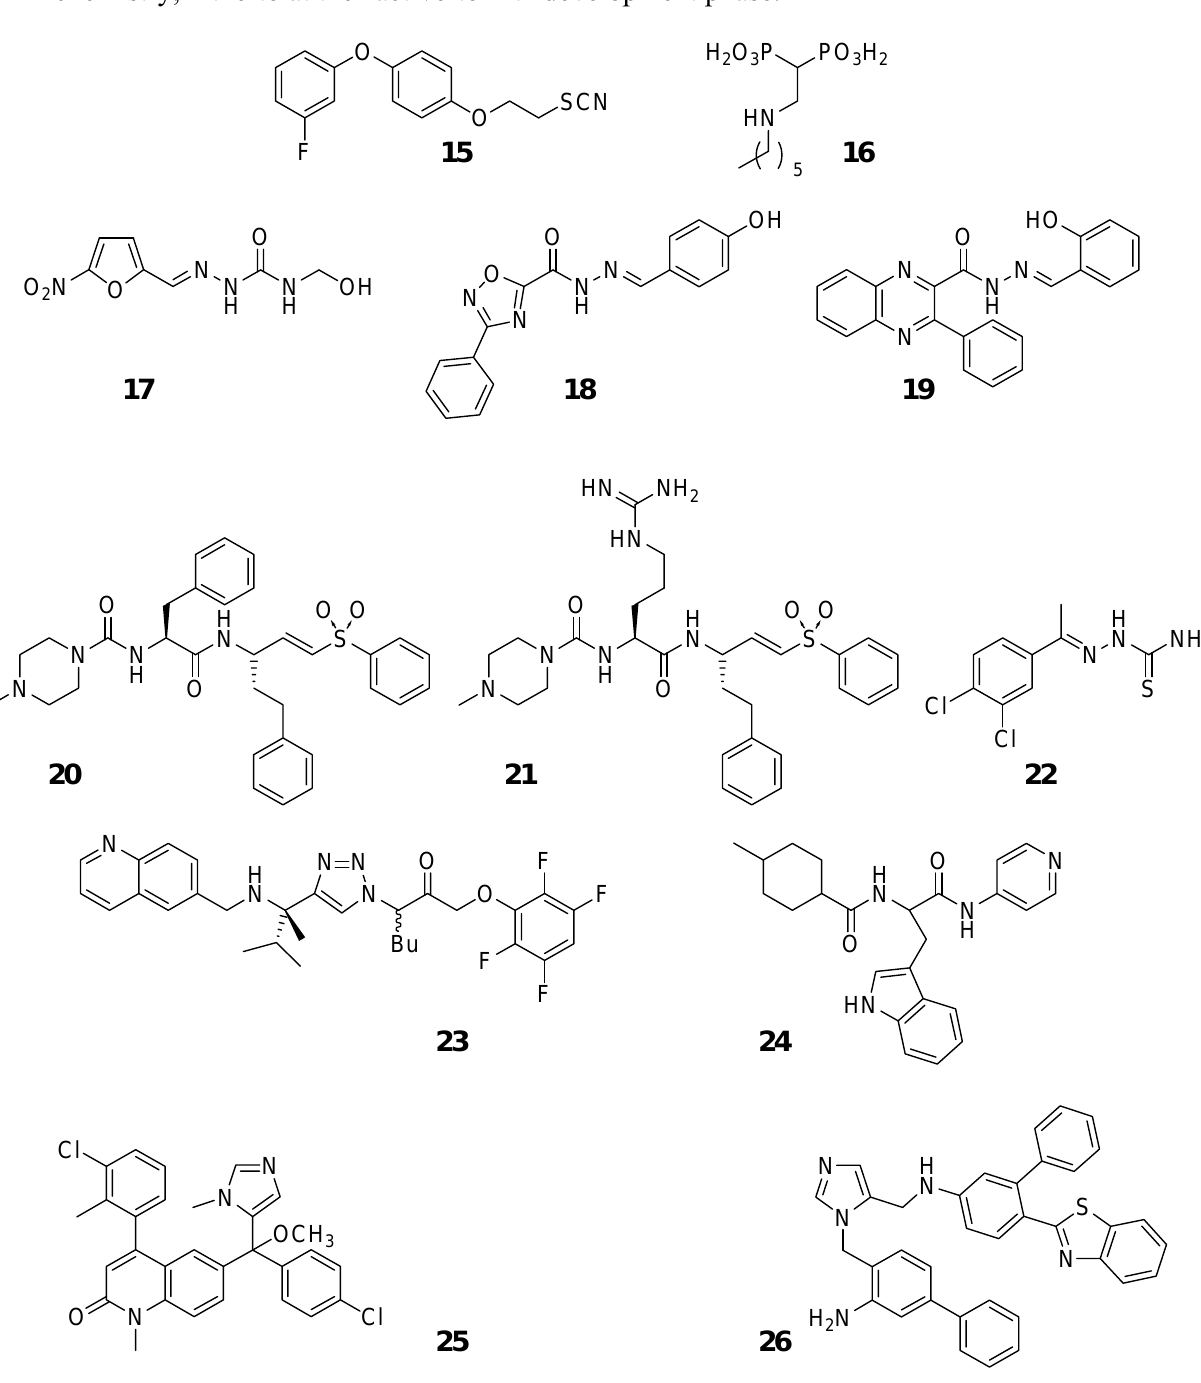
Figure 3. Examples of anti- T. cruzi products emerging from the synthetic medicinal chemistry, hitherto at the “active-to-hit” development